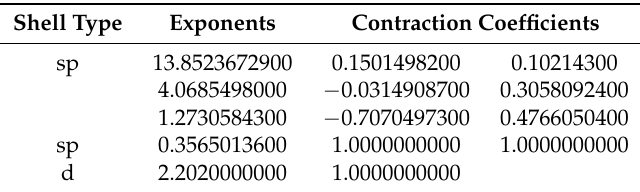
Table A12. Parameters of the cc-DZVP basis set of Neon.